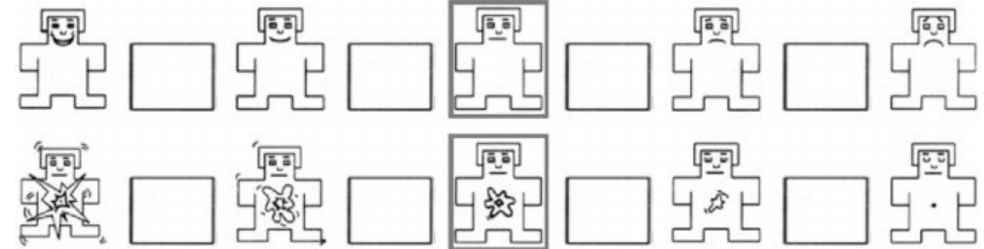
Figure 3. Self-Assessment Manikin (SAM) used for estimating emotions toward music stimuli. The upper scale is for the evaluation of the Valence level. The lower scale is for that of the Arousal level.